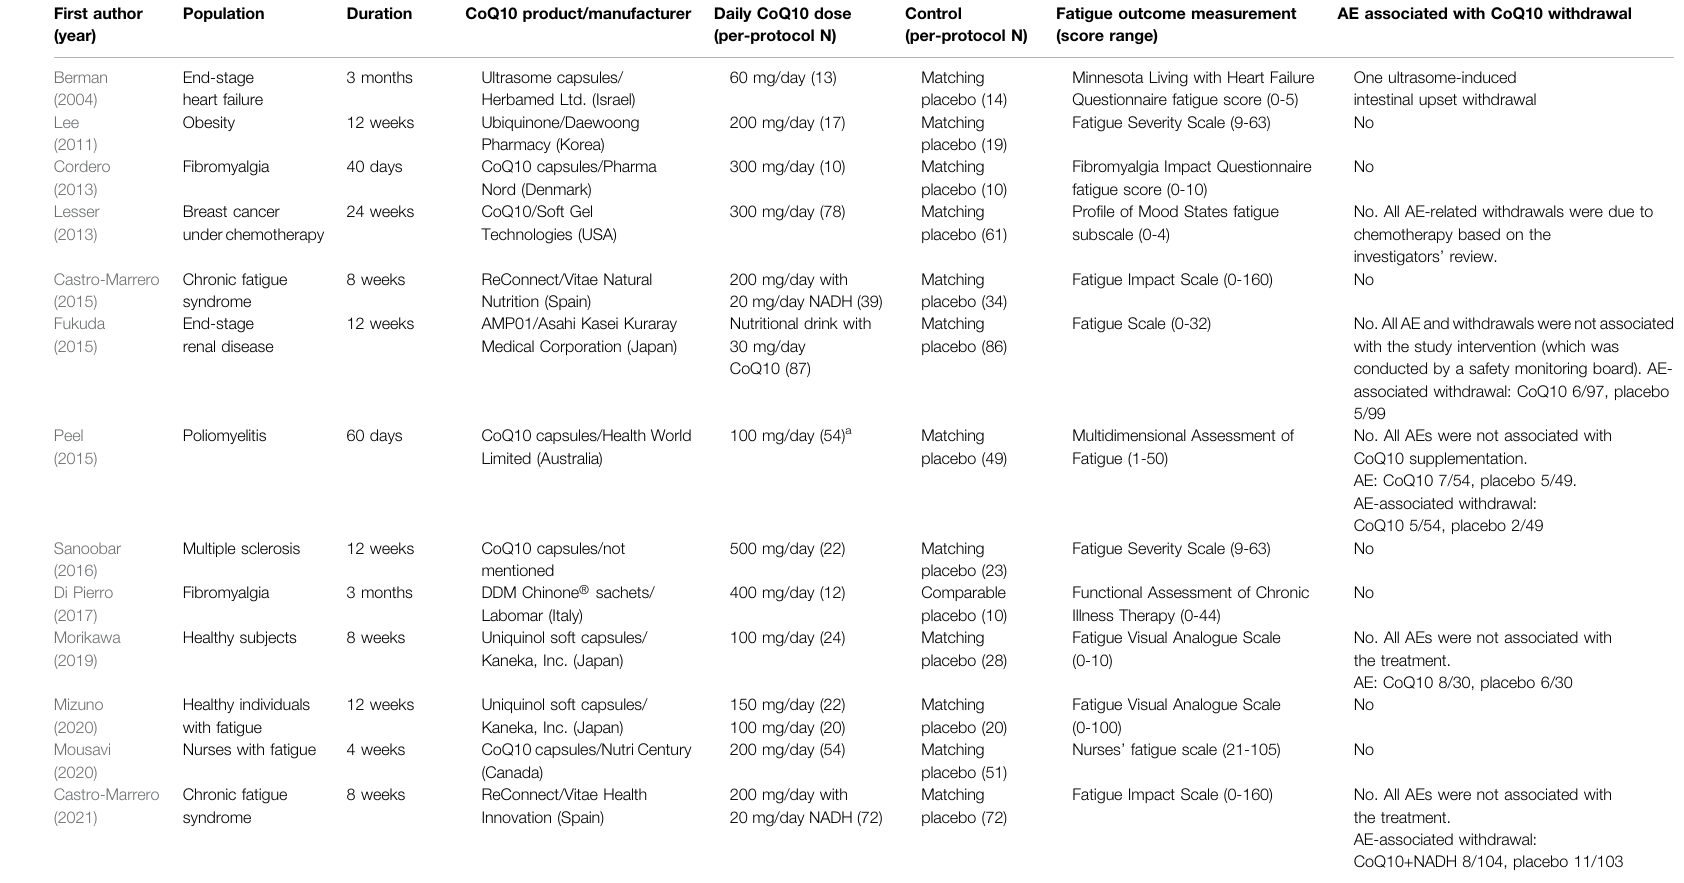
TABLE 2 | Summary of the CoQ10 interventions administered in the study treatment arms of the retrieved